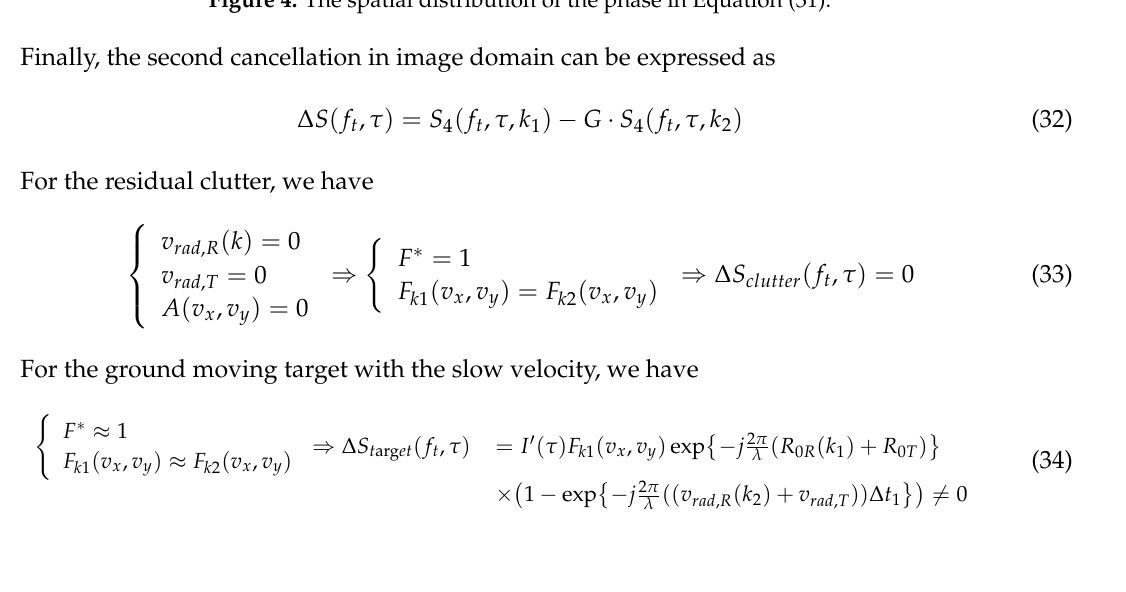
Figure 4. The spatial distribution of the phase in Equation (31).